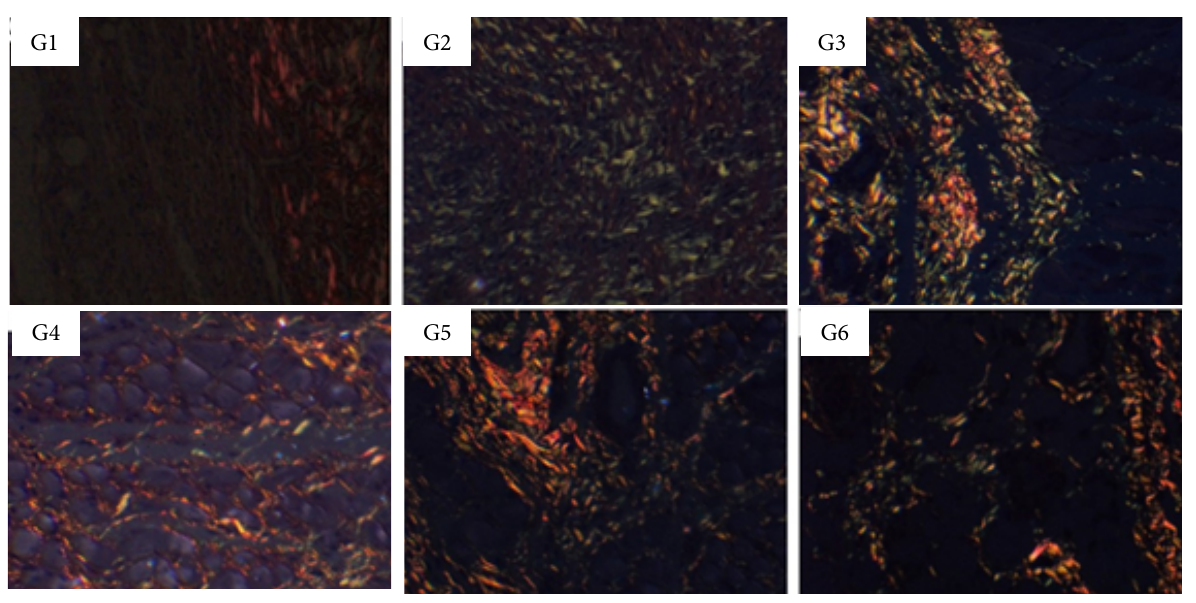
Figure 10 - Collagen fibers deposition in partial thickness burn wounds experimentally induced in Wistar rats seven days after the injury induction (DAI). Collagen fibers type I are shown in red and type III in green. Stain Picrosirius red. Augmentation: 20x scale in μ m.